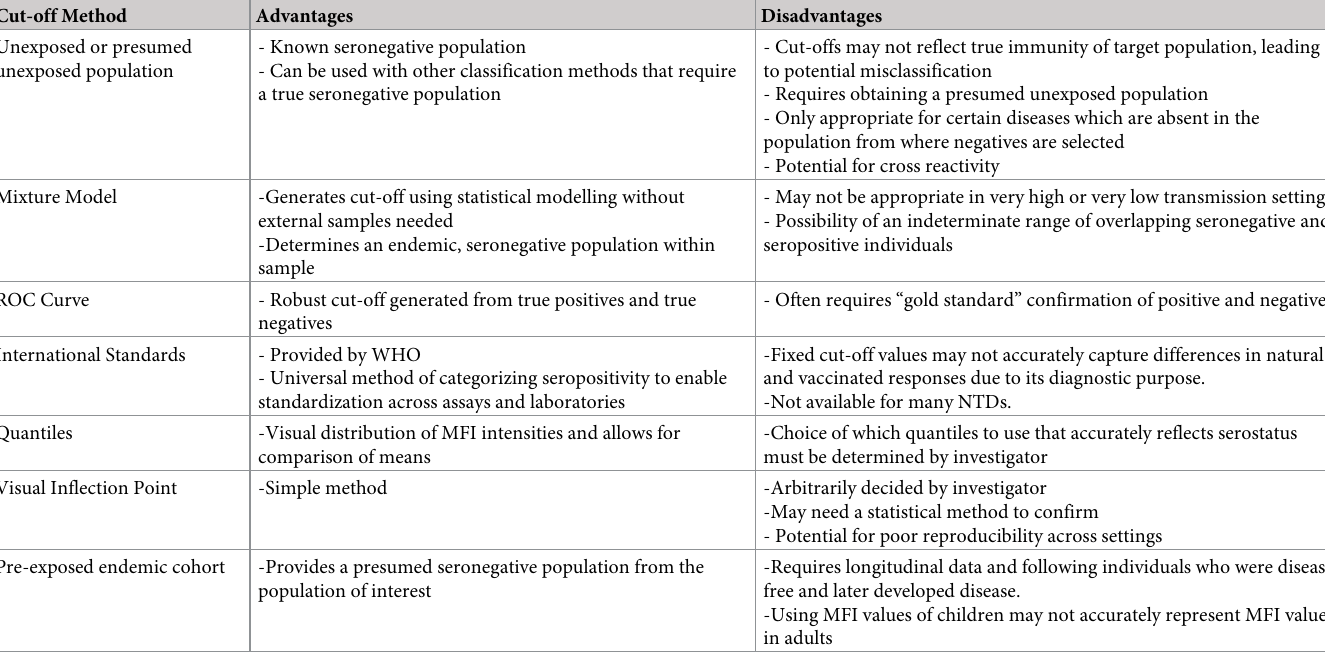
Table 2. Summary of Advantages and Disadvantages of different seropositivity cut-off